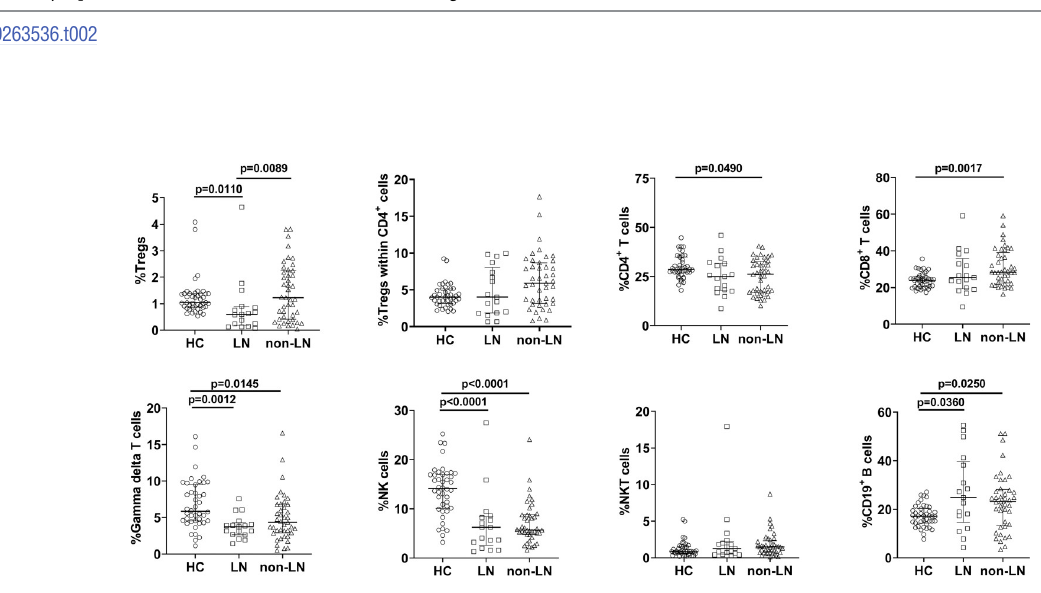
Fig 2. Differences among lymphocyte subsets between non-LN JSLE patients, LN JSLE patients, and HC. The data included 43 non-LN JSLE patients, 17 LN JSLE patients, and 42 age-matched HC. Horizontal solid lines represent medians and interquartile ranges. JSLE, juvenile-onset systemic lupus erythematosus; LN, lupus nephritis; HC, healthy controls; Tregs, regulatory T cells; NK cells, natural killer cells; NKT cells, natural killer T